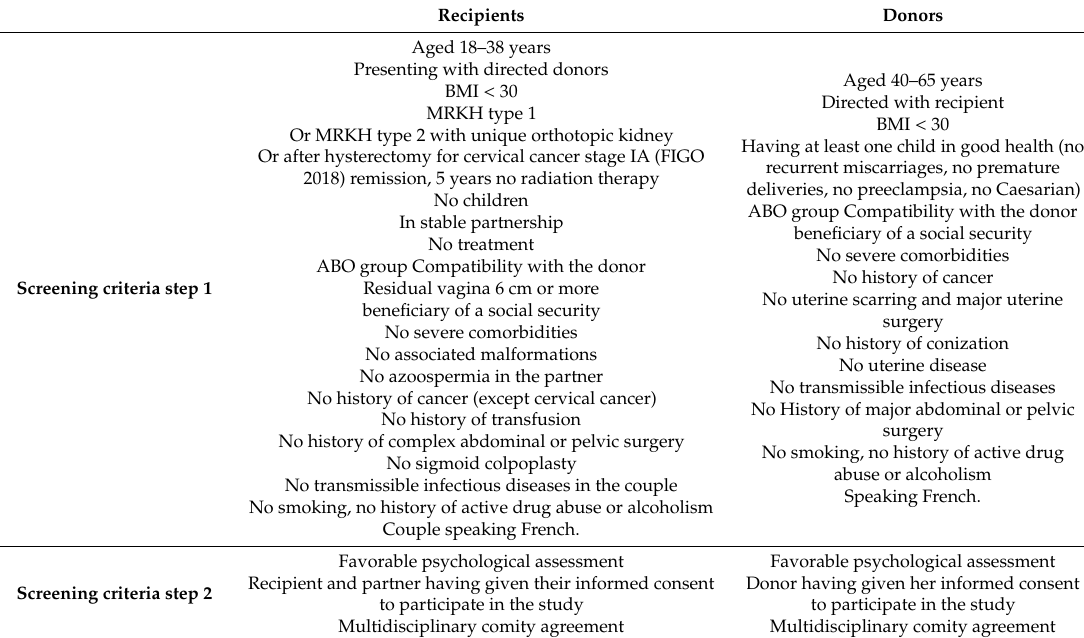
Table 1. Screening and inclusion